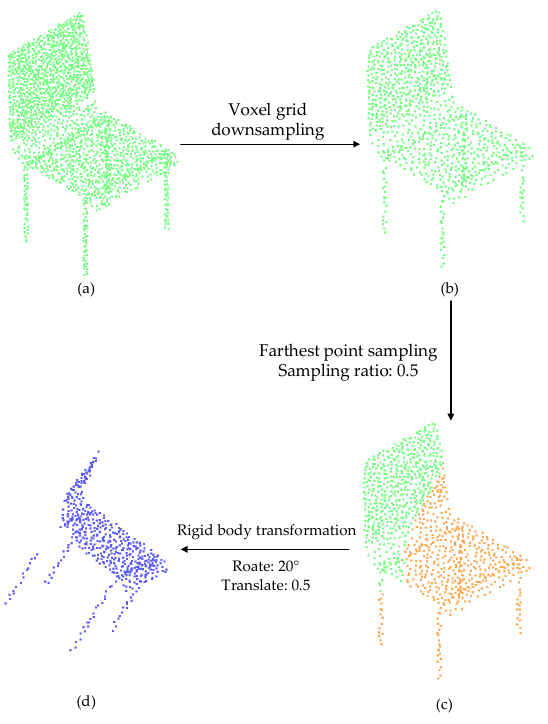
Figure 7. The creation process of a global template point cloud, initial partial point cloud, and partial point cloud: ( a ) Chair model in ModelNet40; ( b ) Global template point cloud; ( c ) Initial partial point cloud; ( d ) Partial point cloud.